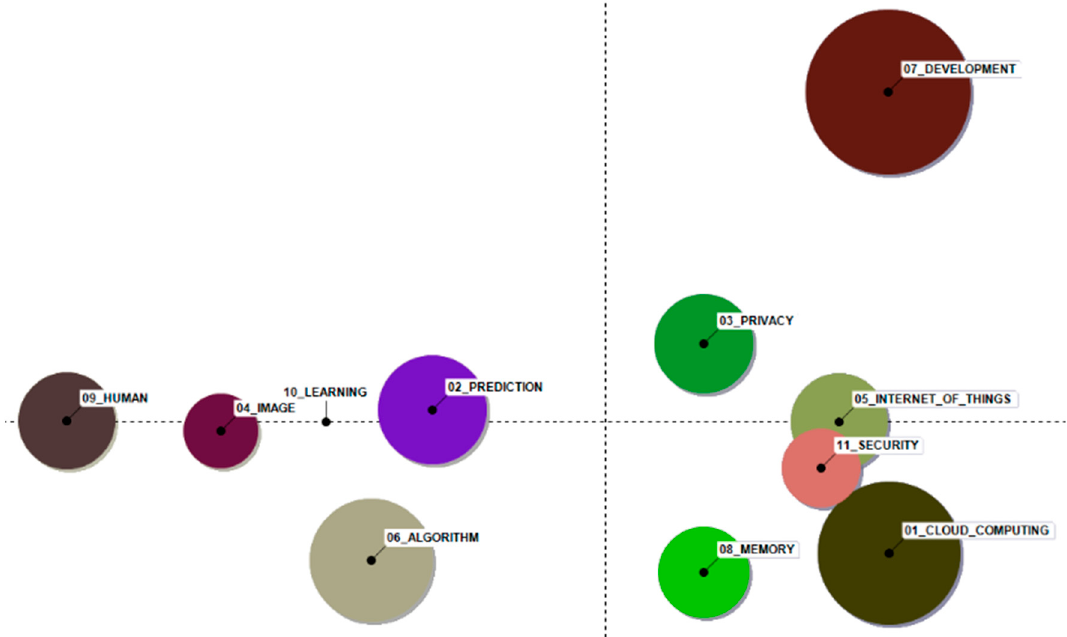
Figure 9. Key-terms clusters visualization (2009–2018).